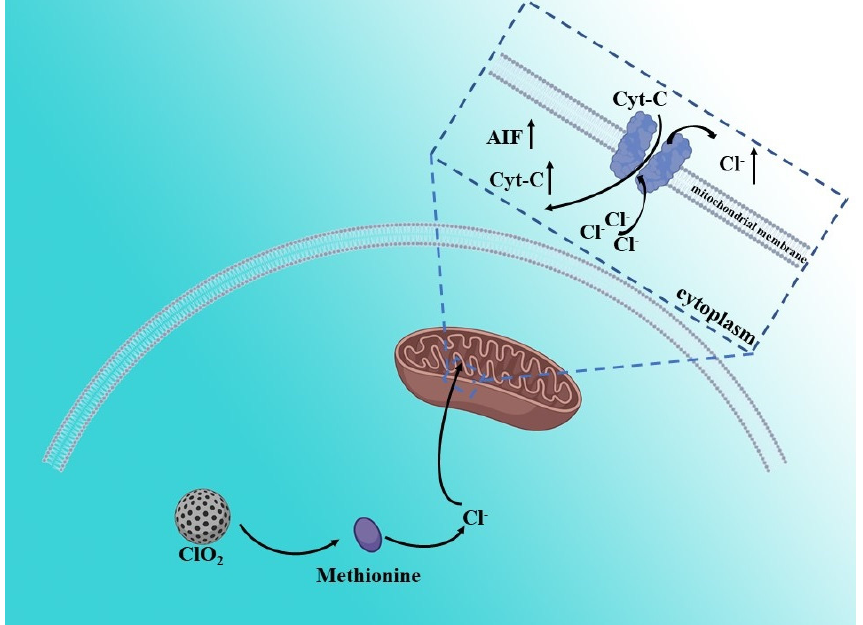
Figure 5. Schematic illustration of Cl − —induced antitumor therapy. The released Cl − by ClO 2 , which can enter mitochondria through the voltage-dependent anion channel (VDAC), leads to mitochondrial damage and membrane potential decline, which further induce cell apoptosis.